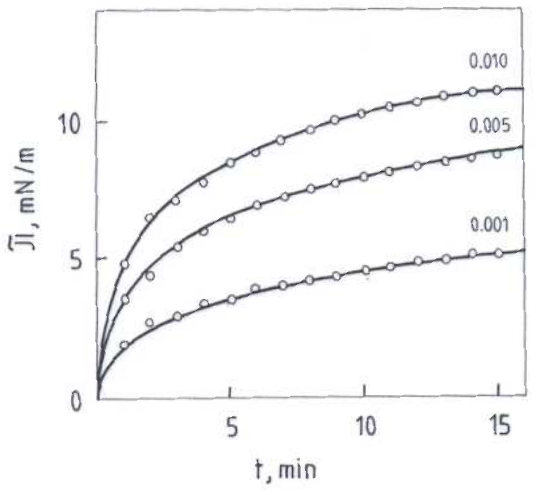
Fig. 2 Dynamic interfacial pressure ( Π in mN/m) of tetracaine aqueous solutions (pH 2) at the benzene/water interface. Figures indicate the tetracaine bulk concentration ( c 0 in mole dm − 3 ).